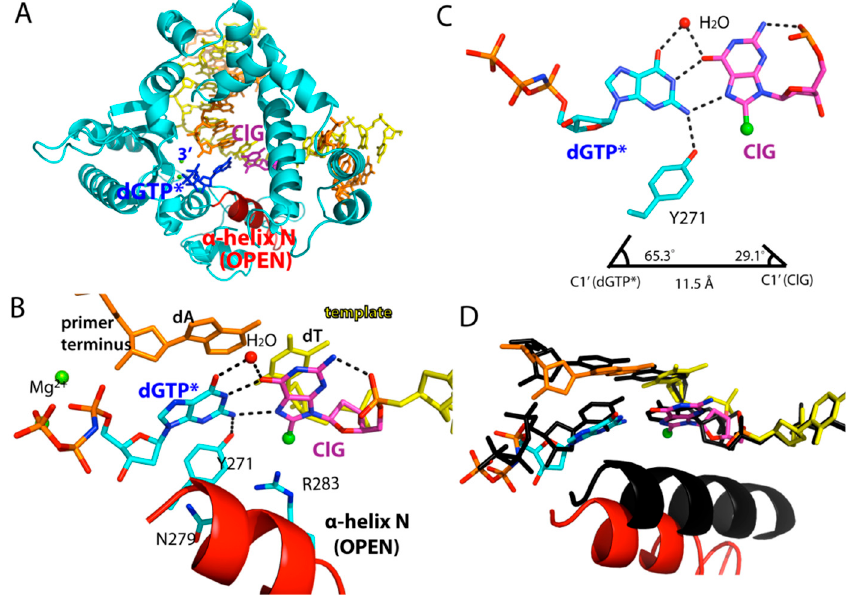
Figure 4. Ternary structure of pol β in complex with ClG:dGTP* base pair. ( A ) Overall view of pol β -ClG:dGTP* ternary complex structure. ClG is in purple; incoming dGTP* in green. α -Helix N takes a semi-open conformation. ( B ) Active-site view of the pol β -ClG:dGTP* structure. The α -helix N is in open conformation. Asn279 and Arg283 do not make minor groove contacts. Hydrogen bonds are indicated in dotted lines. ( C ) Base pair geometry of ClG and dGTP*. Note that the ClG takes a syn conformation, forming H-bonds with incoming dGTP* via its Hoogsteen edge and water mediation. ( D ) Superposition of the pol β -ClG:dGTP* ternary complex structure (multicolor) with the pol β -dA:dUTP* ternary complex structure